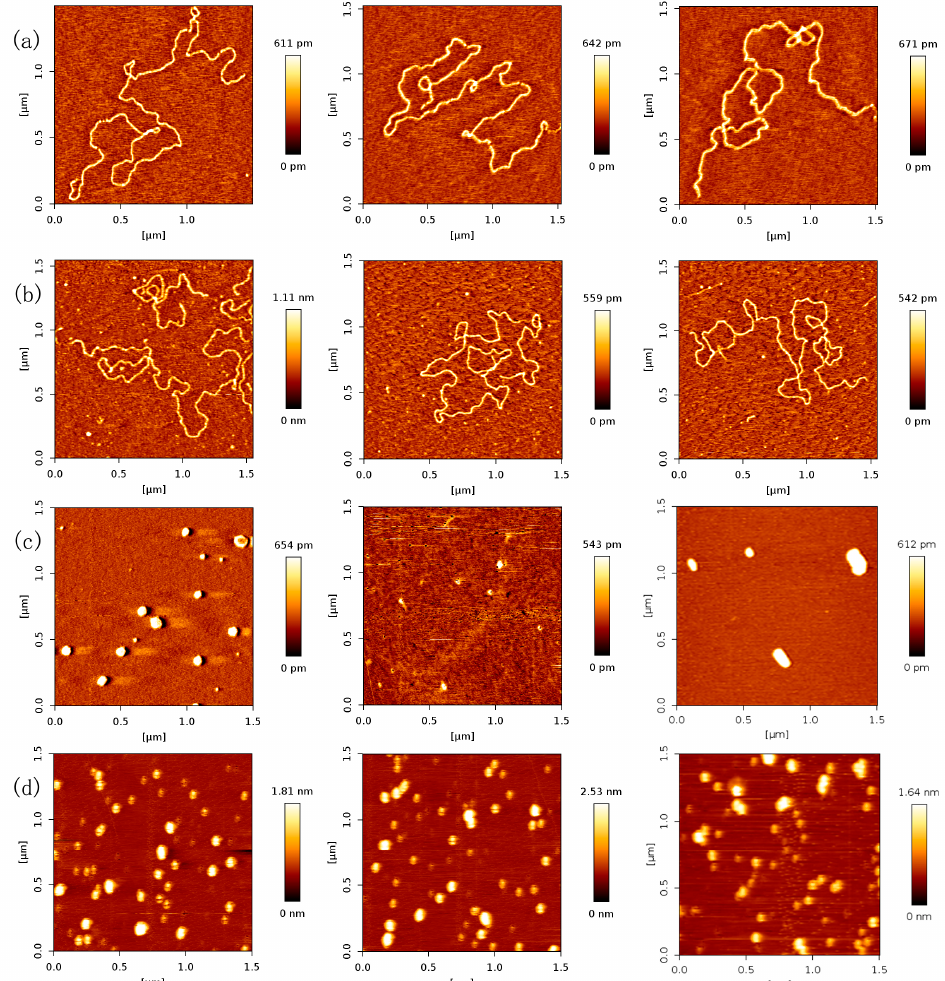
Figure 1. Atomic force microscopy (AFM) images of DNA and p53 (height images, 1.5 µm × 1.5 µm). ( a ) AFM images with control DNA molecules in relaxed conformations, respectively. The environment of the solution is 5 mM Hepes, 3 mM MgCl 2 , pH 7.5, and the concentration of DNA is 1 ng/µL; ( b ) AFM images with control DNA molecules in relaxed conformations, respectively. The environment of the solution is 5 mM Tris, 3 mM MgCl 2 , pH 7.5, and the concentration of DNA is 1 ng/µL; ( c ) AFM images with control p53 molecules in white dot conformations, respectively. The environment of the solution is 5 mM Hepes, 3 mM MgCl 2 , pH 7.5, and the concentration of p53 is 2 ng/µL; ( d ) AFM images with control p53 molecules in white dot conformations, respectively. The environment of the solution is 5 mM Tris, 3 mM MgCl 2 , pH 7.5, and the concentration of p53 is 2 ng/µL.